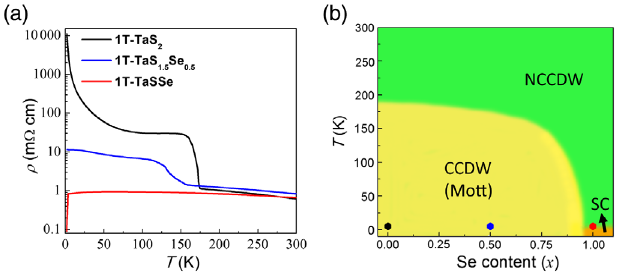
3. (a) Temperature dependence of the in-plane resistivity of three typical 1 T-TaS 2 − phase diagram of 1 T-TaS 2 − samples under STM